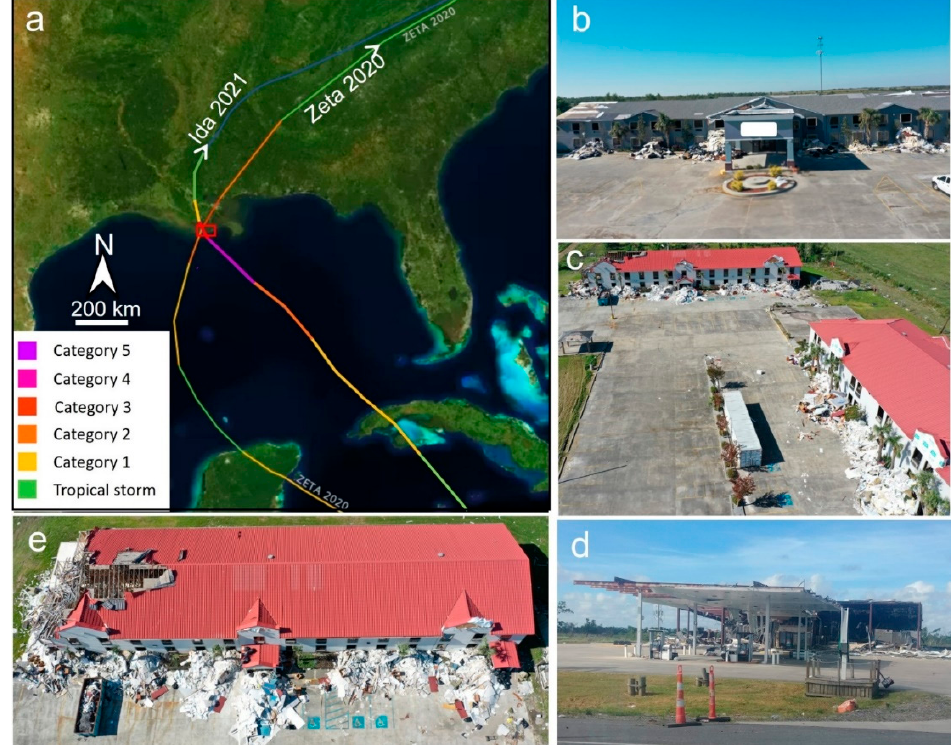
Figure 2. ( a ) Storm tracks (https://coast.noaa.gov/hurricanes, accessed on 10 May 2022) of Hurricane Ida and Zeta. The red box marks our study area, the coastal town of Port Fourchon. ( b – e ) Drone images showing Ida’s impact on Port Fourchon.